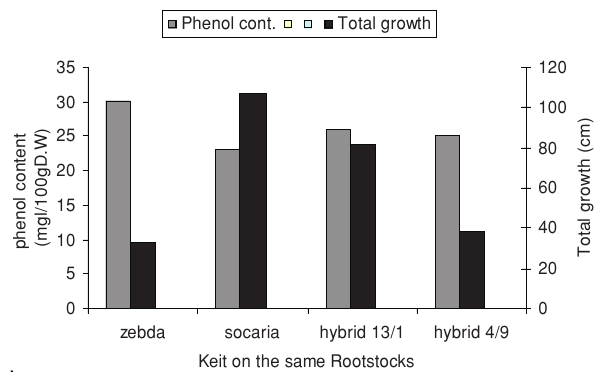
Fig 2. Relationship between total phenols content (mg/100g dry weight) and total growth of Keit mango as affected by grafting on tested rootstocks